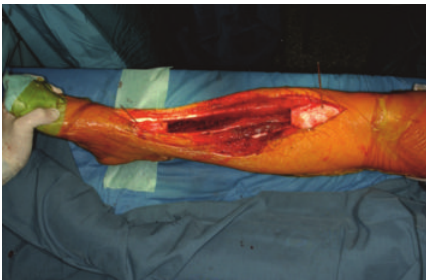
Figure 3: Intraoperative photograph after the wide resection of the adamantinoma (21cm of the tibia, 19cm of the fibula) was performed.